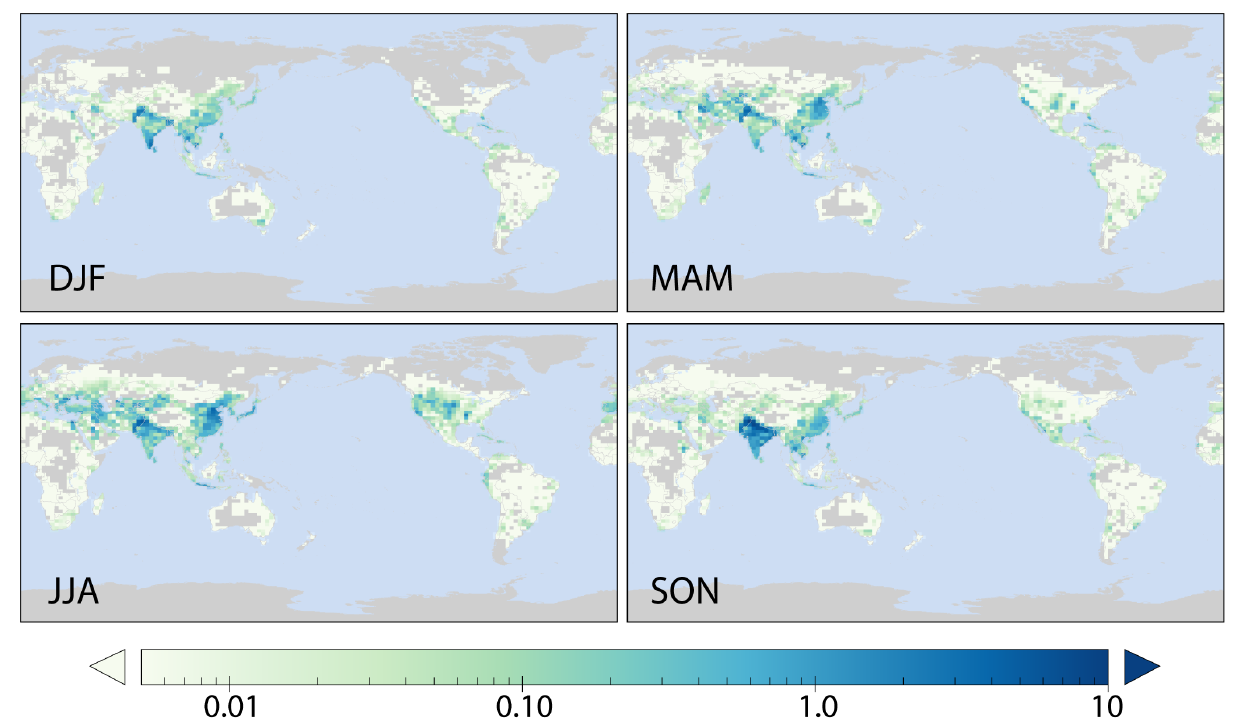
Figure 1. Applied irrigation by season (mm per day). The scale is logarithmic. Land with no irrigation applied is shown in gray.